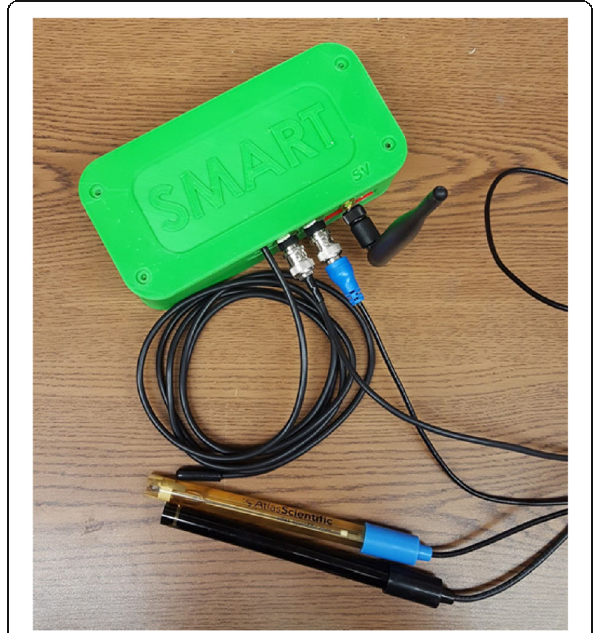
Fig. 3 UMaine designed Wireless Stormwater Data Acquisition